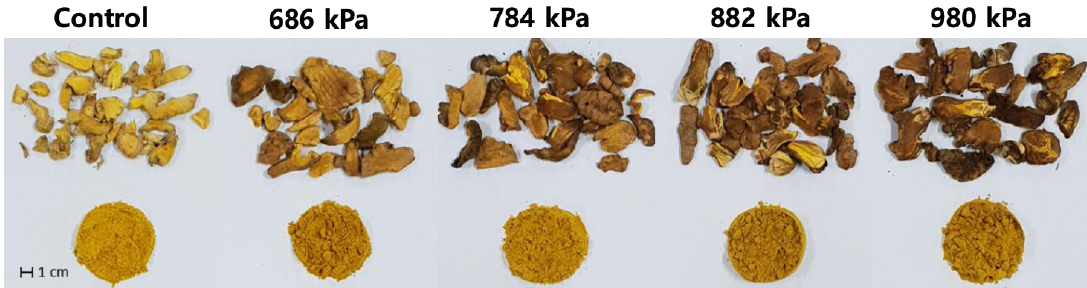
Figure 1. Morphological change of turmeric caused by puffing at various pressures. Darkening of the turmeric correlated with increased puffing pressure was observed in both the puffed material (upper) and ground powder (lower).